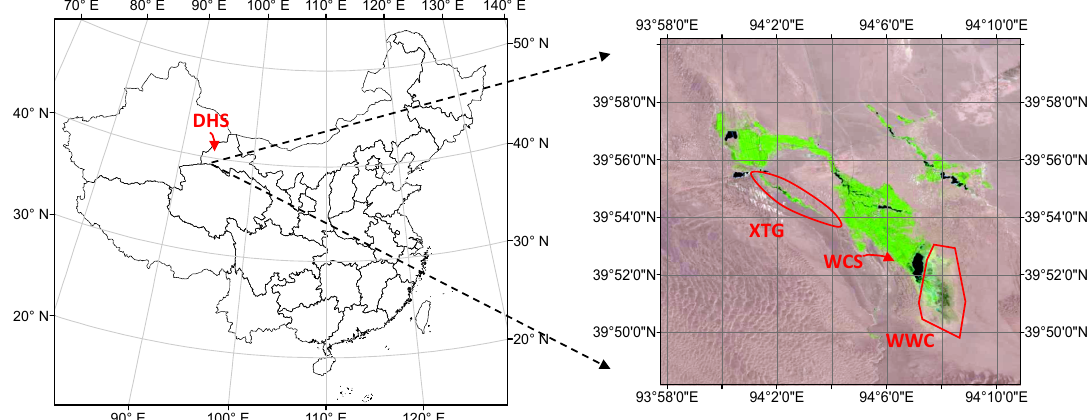
Figure 1. The locations of the two wetlands, i.e., Xitugou (XTG) and Wowachi (WWC), inside the Yangguan National Nature Reserve (YNNR) in the Gansu Province of China. The arrows marked DHS (Dunhuang Station) and WCS (Wowachi Station) point to the locations of the Dunhuang weather station and the Wowachi automatic weather station,